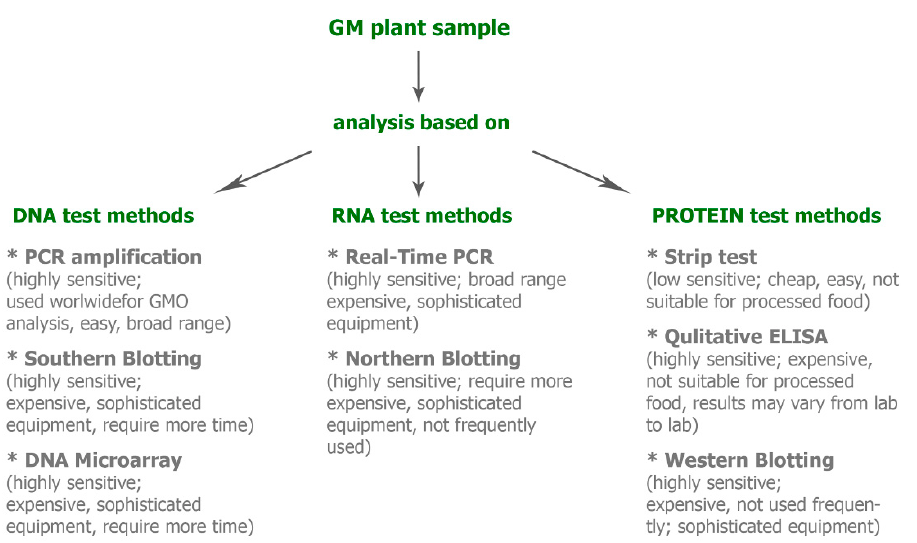
Figure 2. Molecular methods for analysing genetically modified (GM) plants.